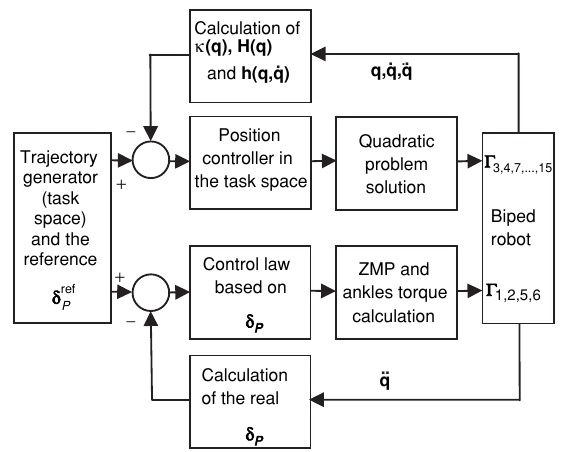
Figure 3 The two controllers acting on the biped robot: No. 1, 2, 5, 6, stand for the ankles, No. 3, 4, 7 . . . 15 for the other joints.